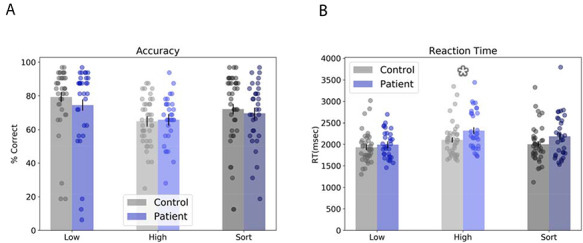
Behavioral results. (A) Subjects were more accurate on low trials than on high and sort trials, and less accurate on high than sort trials. (B) Similarly, subjects showed the fastest reaction time on low trials, and a slower reaction time on high trials than on sort trials. In addition, patients were significantly slower than controls on the high trials. Bars represent mean ± SEM. Circles represent individual data points. *Pairwise P-value < 0.05.